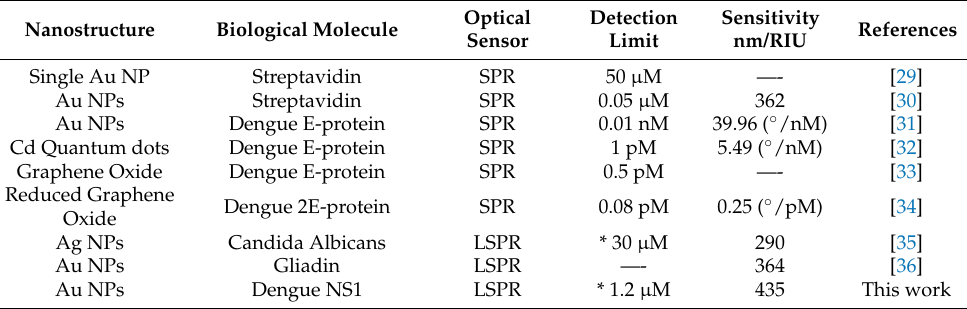
Table 2. Comparison of SPR- and LSPR-based biosensors for biological molecules